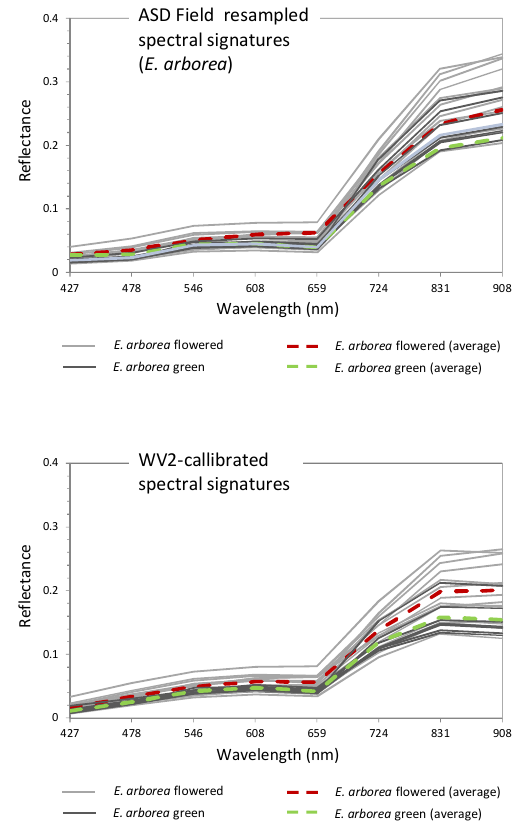
Figure 2. Empirical calibration of field spectra from Erica arborea measurements for endmember extraction in WV2 image. Two patterns noticeable between different phenological